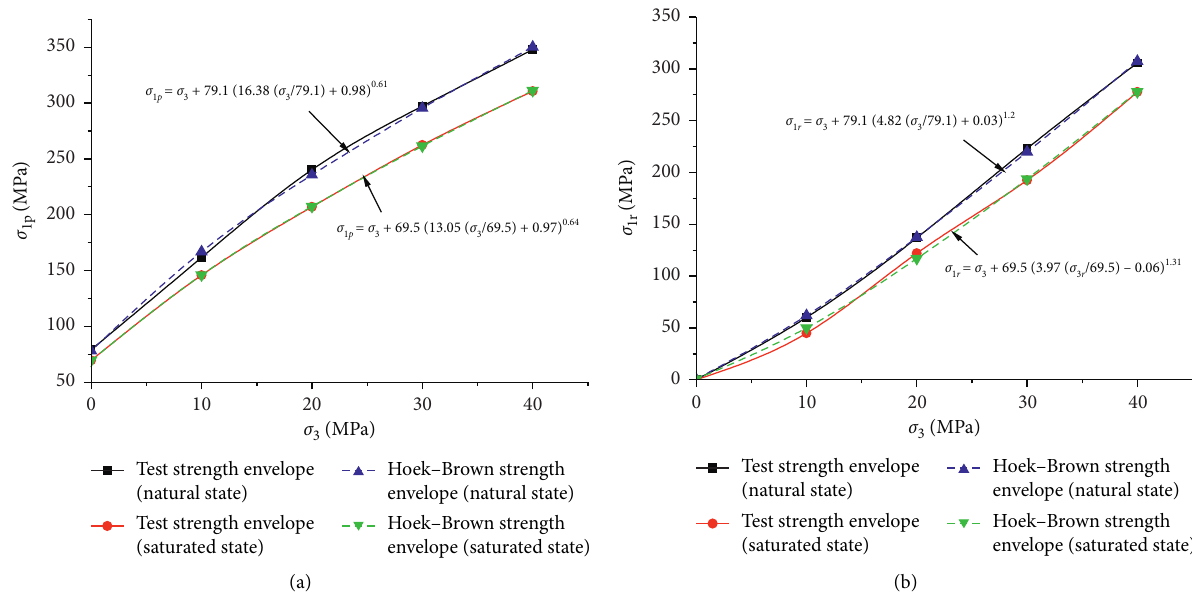
Figure 13: Strength envelopes of Yunnan limestone. (a) Peak strength envelope. (b) Residual strength envelope. σ peak and residual maximum principal stress at confining pressure σ 3 ,